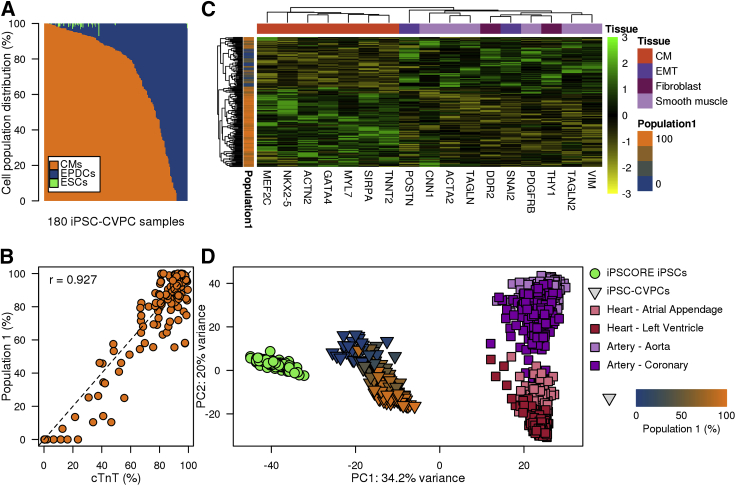
Transcriptomic Features of 180 iPSC-CVPC Samples(A) Relative distributions of cell populations estimated using CIBERSORT across 180 iPSC-CVPC samples.(B) Scatterplot showing the correlation between %cTnT (x axis) and the fraction of population 1 in the iPSC-CVPCs calculated using CIBERSORT (y axis).(C) Heatmap showing the expression levels of CM and EPDC marker genes (Figure 1J) in 180 iPSC-CVPC samples. Samples are colored based on their fraction of population 1.(D) PCA of the 1,000 genes with highest variability from 184 iPSC samples, 180 iPSC-CVPCs (triangles colored according to their percentage of population 1), and samples from GTEx (squares—left ventricle, right ventricle, coronary artery, and aorta).